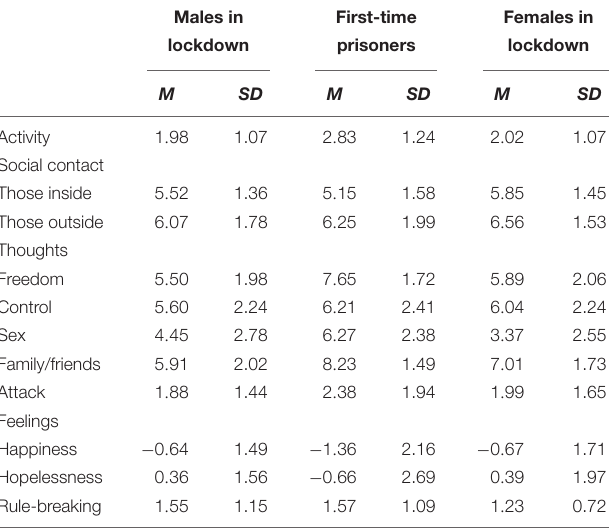
TABLE 3A | Means and standard deviations of dependent variables by group (UK